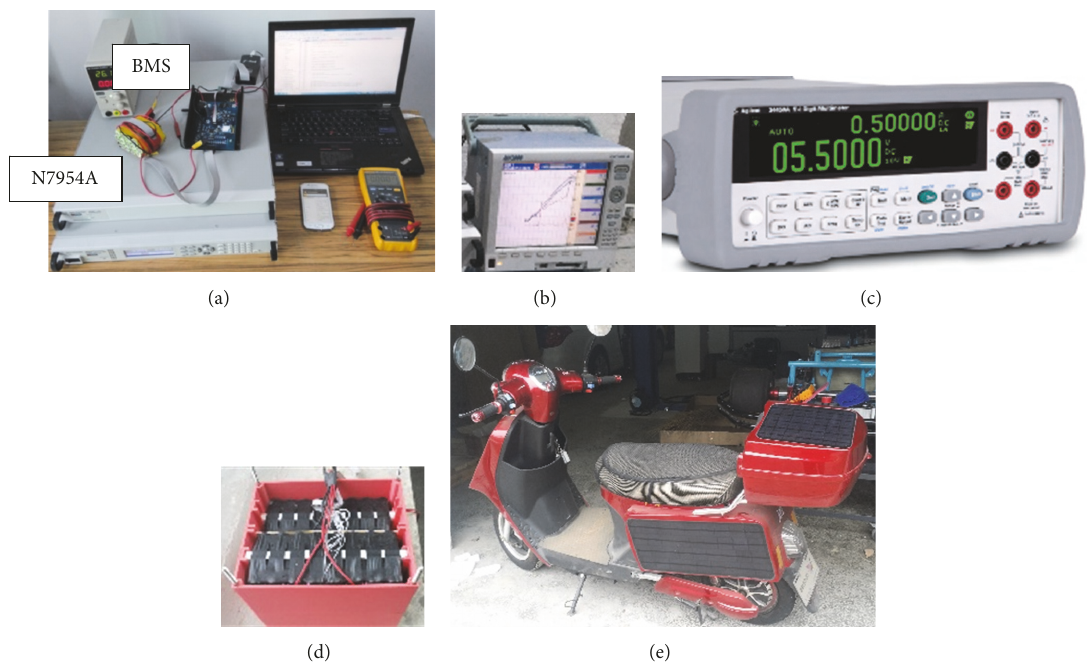
Figure 9: Pictures of the laboratory equipment (a, b, c), battery pack (d), and e-bike